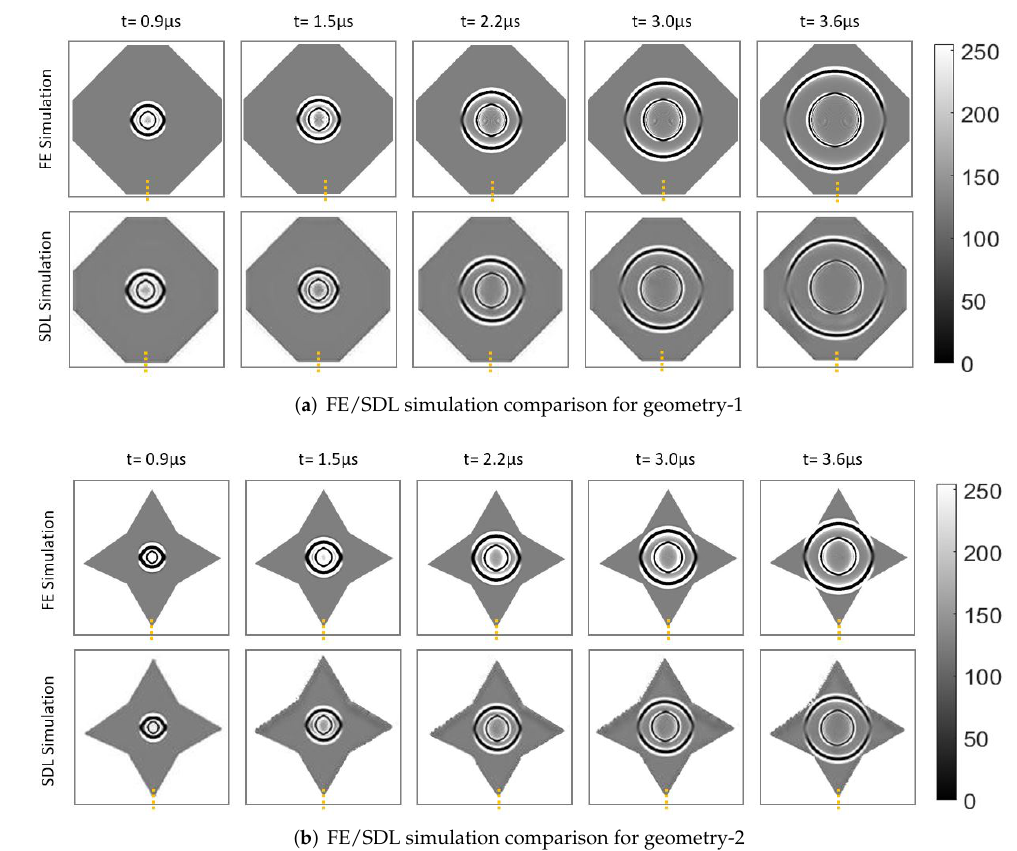
Figure 4. Forward wave propagation of different geometrical domain: The FE and SDL are modeled using 5 MHz central frequency and two cycles with a single-point excitation source on different geometrical domains. The SDL model predicted simulations are qualitatively compared with FE sim- ulation. ( a ) Forward wave propagation simulation for geometry-1 and ( b ) forward wave propagation simulation for geometry-2, at exact time steps for different time